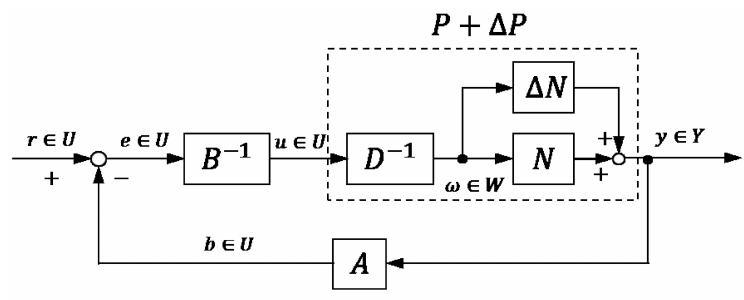
Figure 4. The nonlinear feedback control